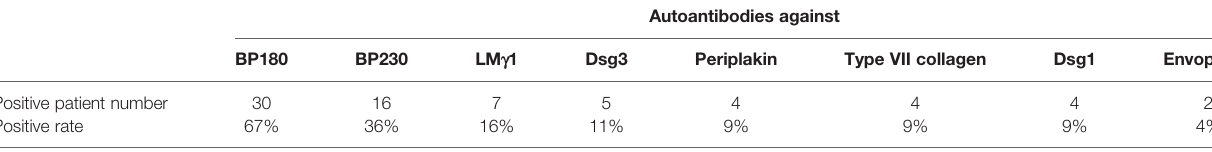
TABLE 3 | The detailed autoantibody information of the 45 patients in multiple-Ags group.